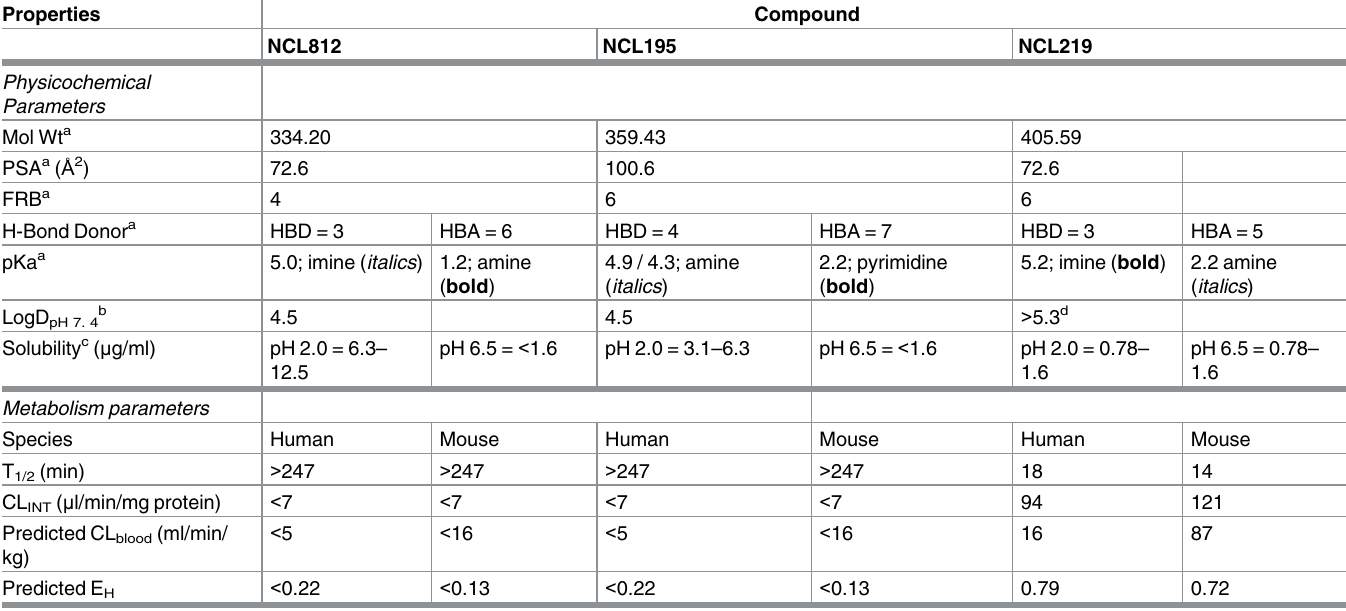
Table 3. Physicochemical and metabolism parameters for NCL812, NCL195 and NCL219 in human and mouse liver microsomes.